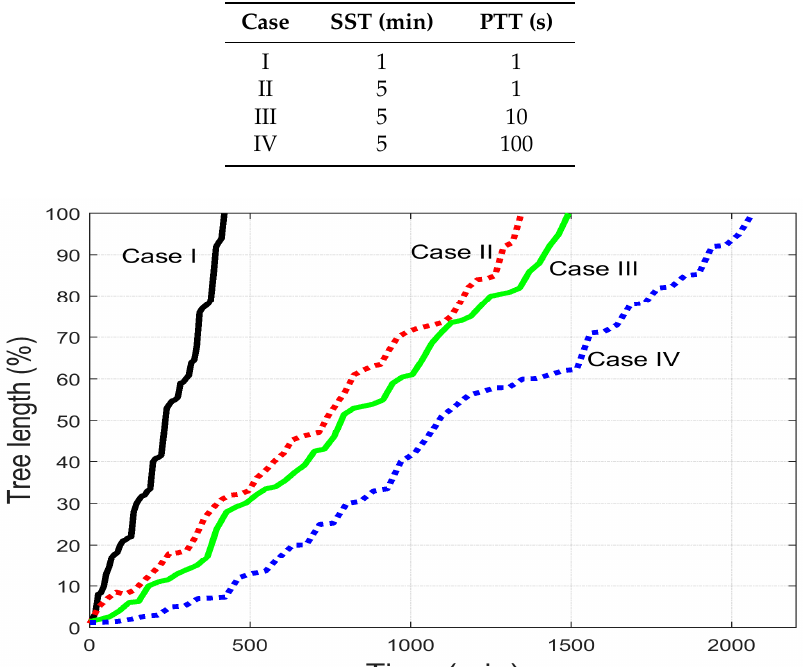
Table 4. Characteristics of the applied polarity reversing voltages.